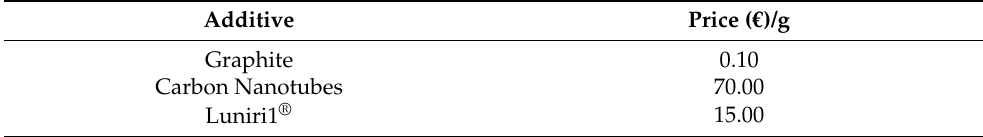
Table 2. A comparison on price for different additives.